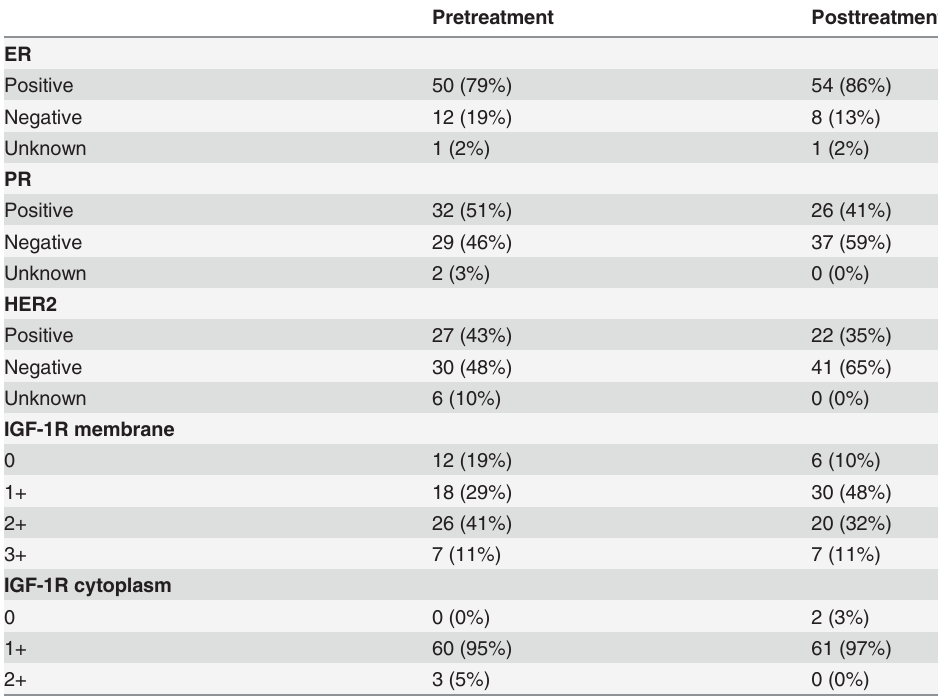
Table 3. Immunohistochemical markers of the 63 breast tumors.